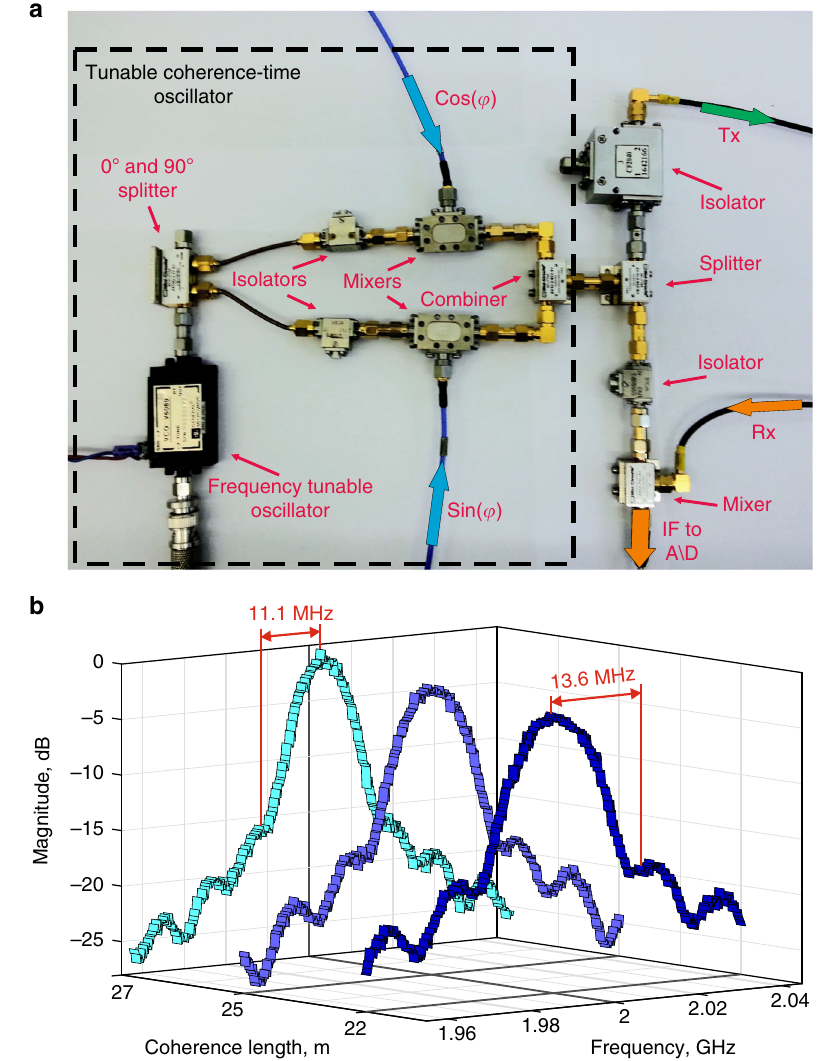
Fig. 4 Experimental implementation and transmitted bandwidth measurements. a Photograph of the partially coherent oscillator implementation. A carrier is split into two quadratures, where one arm is phase delayed by 90°. Each arm is multiplied by an appropriate sine or cosine term of the desired random phase output at time t , and the two arms are combined together to reveal a single carrier with the desired phase jumps, implementing and IQ vector modulator. b Measured half-bandwidth of the radar as it sweeps from coherence length of 22 – 27 m, corresponding to transmitted bandwidths of between 27.2 and 22 MHz. The peaks of the “ sinc ” function are lowered with increasing bandwidth, conserving the transmitted power throughout the sweep. These signals were used to explore the scenarios shown in Fig.